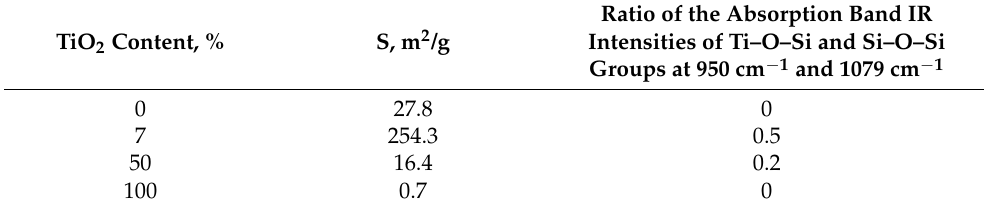
Ratio of the Absorption Band IR